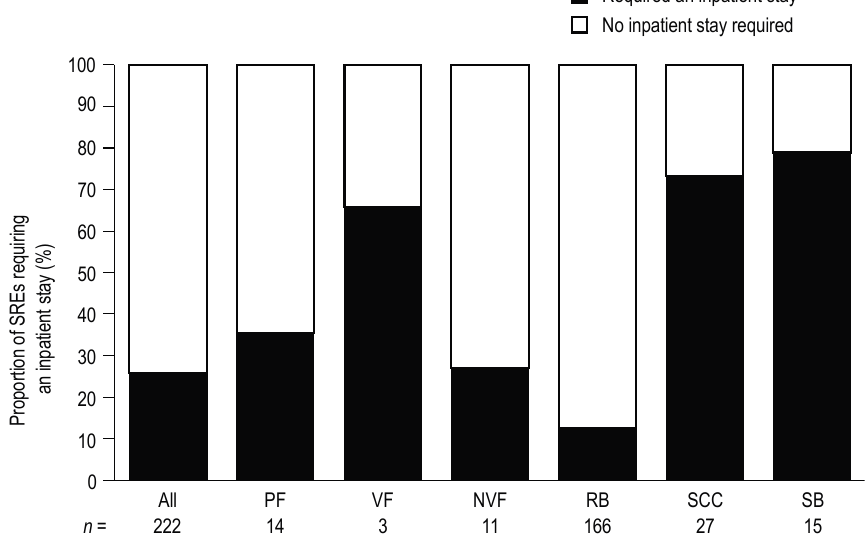
Figure 1. Proportion of skeletal related events (SREs) requiring an inpatient stay. Data show the proportion of SREs requiring an inpatient stay versus the proportion of SREs that did not require an inpatient stay. Data for PF are shown first overall, and then by VF and NVF subcategories.